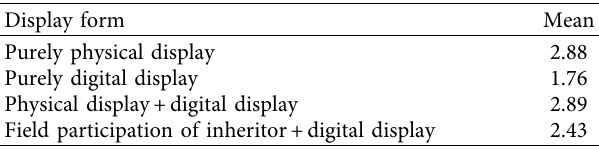
Table 16: Degree of preference for different ICH display